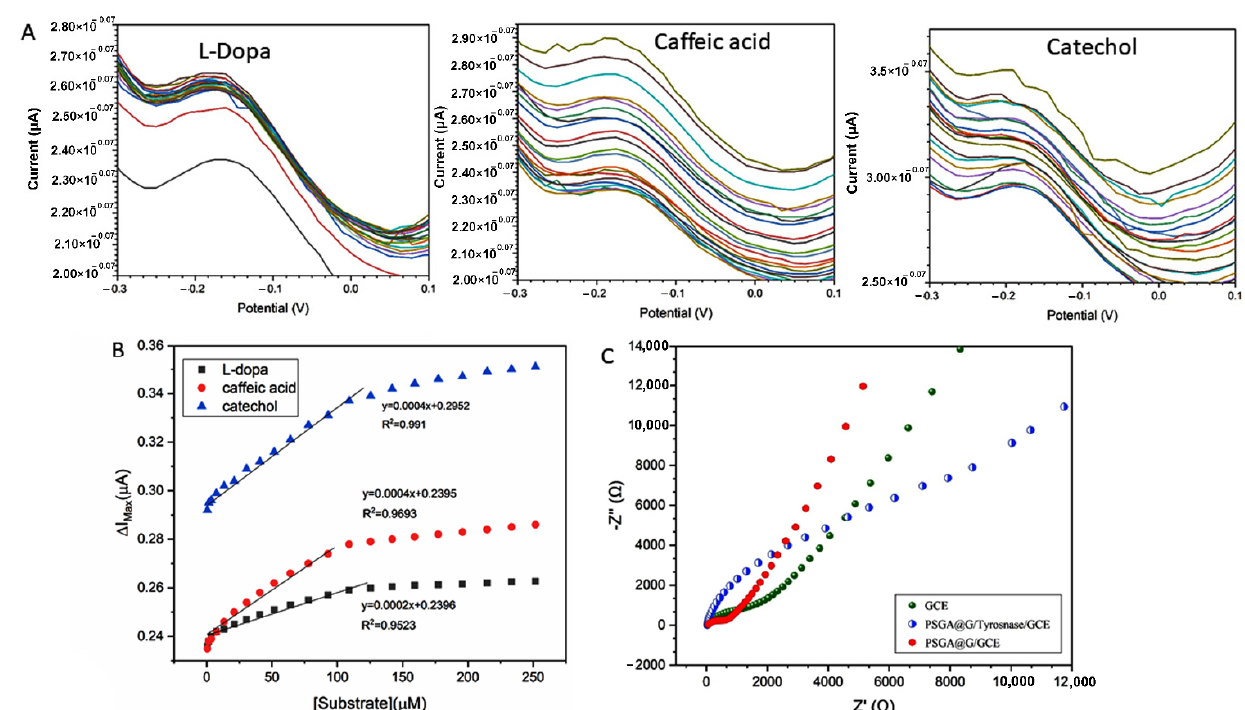
Figure 7. ( A ) Differential pulse voltammetry (DPV) of SSt- g -PANI@G/tyrosinase /GCE in the pres- ence of L-dopa, catechol, and caffeic acid; ( B ) the Michaelis–Menten diagrams for the three substrates of L-dopa, caffeic acid, and catechol; ( C ) Nyquist plots of the bare GCE, SSt- g -PANI@G/GCE and SSt- g -PANI@G/Tyase/GCE in 1.0 mM [Fe(CN) 6 ] 3 − /4 − redox probe and 0.1 M KCl as the supporting electrolyte. The frequency ranges of 0.1 to 100,000 Hz, with AC amplitude potentials of 0.005 V and DC amplitude of 0.3 V were